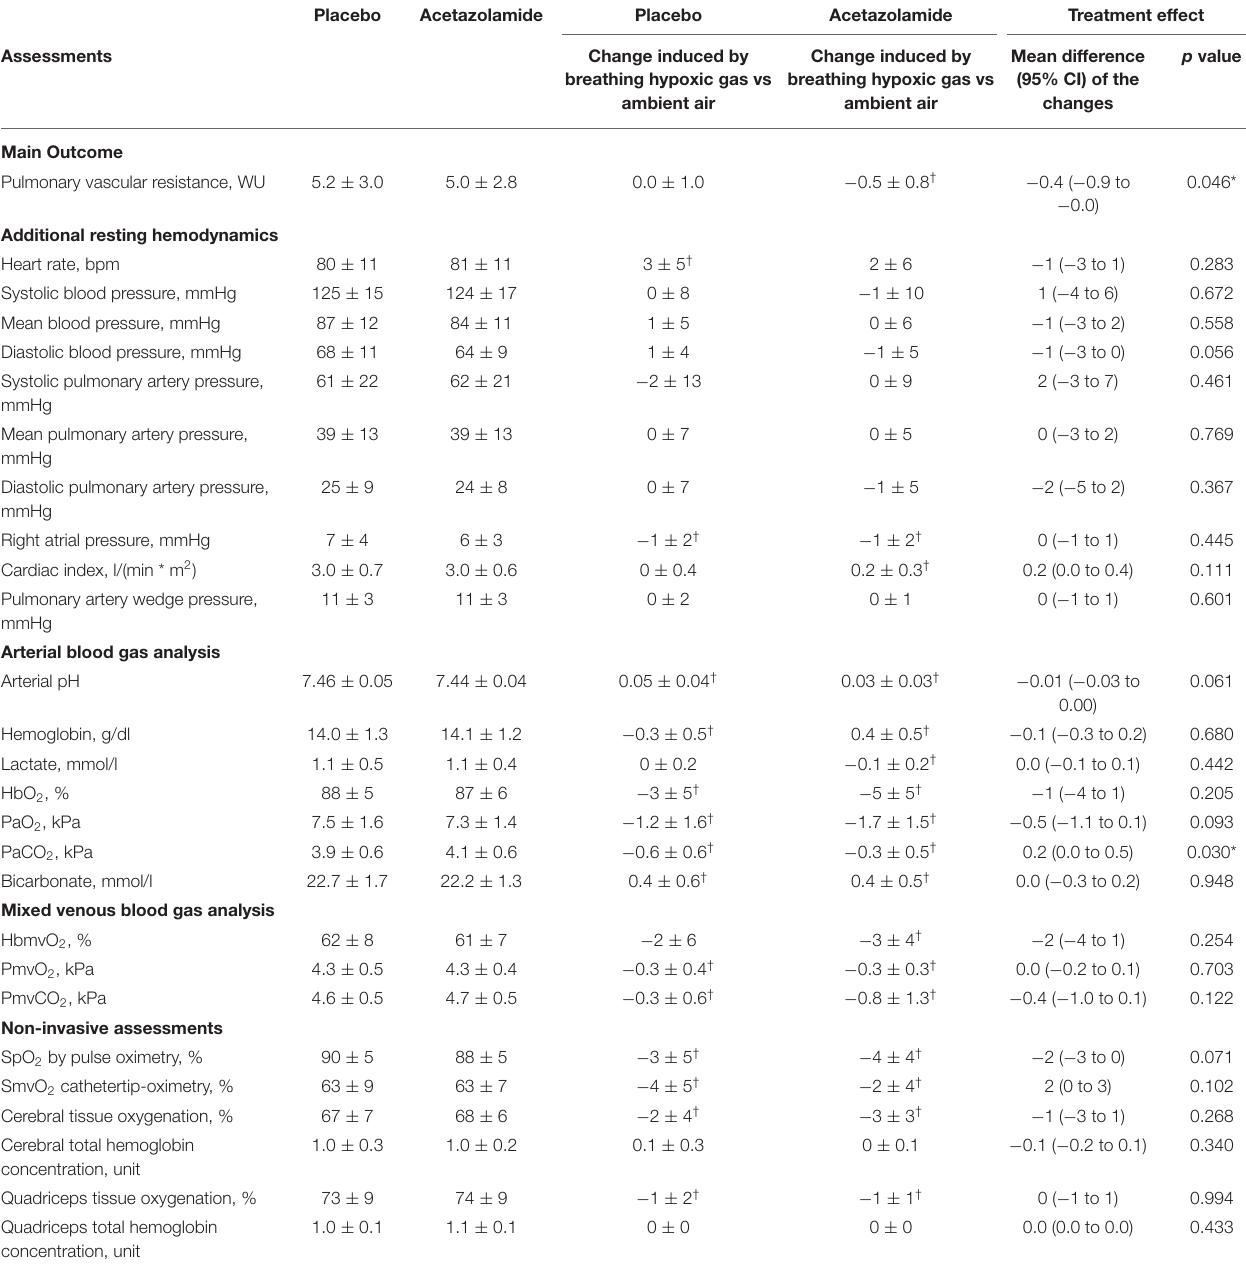
TABLE 3 | The effect of acetazolamide vs. placebo on invasive pulmonary hemodynamics, blood gases and tissue oxygenation after 60min under hypoxic gas. Placebo Acetazolamide Placebo